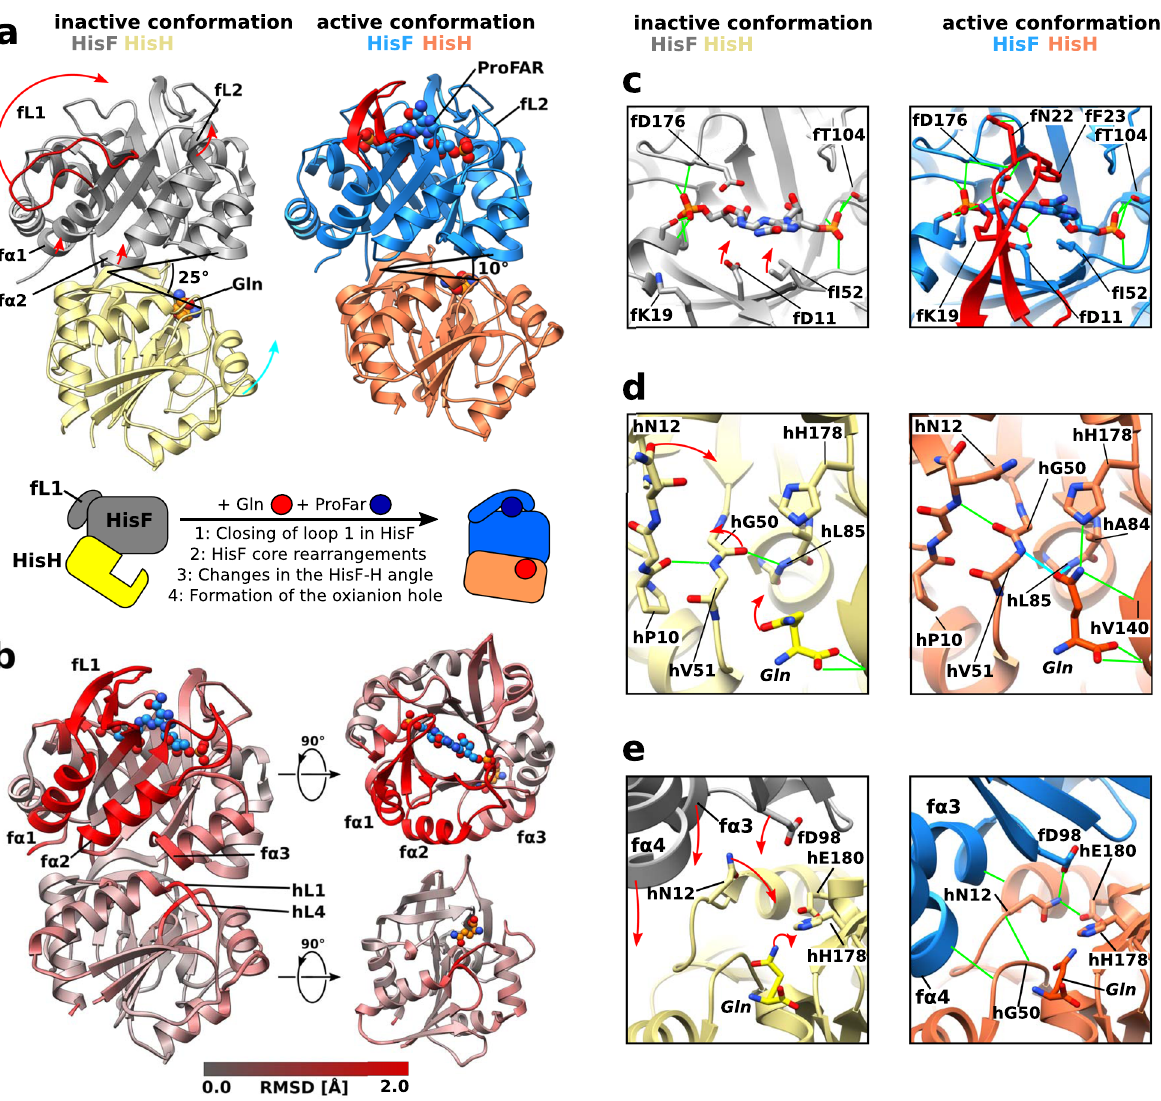
Fig. 2 Structural changes in the HisFH complex upon allosteric activation. a Crystal structure of the HisFH complex (hC84A) in the inactive conformation (HisF in gray, HisH in yellow; PDBID: 7AC8, chains C/D) bound to Gln (left) and in the active conformation (HisF in marine, HisH in orange, chains E/F) bound to ProFAR and Gln (right). The largest structural differences between the two conformations are observed in HisF (red arrows). The reorientation of HisH relative to HisF is indicated by a cyan arrow and leads to a reduction of the angle between fF120, hW123 and hG52 (C α atoms) from 25° to 10°. The major structural changes between the inactive and active conformations are indicated as cartoons. b The local backbone RMSD between the inactive and active conformations (PDBID 7AC8, chains C/D and E/F), after individual alignment of the proteins, mapped onto the structure of the active conformation. c Closeup of the HisF active site: Comparison between the inactive (left; PDBID 7AC8; chain A) and the active conformation (right; PDBID 7AC8, chain E). Important hydrogen bond interactions are shown in green. fL1 is shown in red. The compaction of the HisF active site in the active conformation is indicated by red arrows. d Oxyanion hole formation in the active conformation of HisH: The oxyanion hole is not formed in the inactive conformation (left; PDBID 7AC8, chain D). Red arrows indicate important conformational changes upon formation of the active conformation. The oxyanion hole (right; PDBID 7AC8, chain F) is formed by the rotation of the hG50/hV51 amide group. The side chain of the substrate Gln rotates into the oxyanion hole and forms hydrogen bonds to hG50 and hL85 (cyan). Other hydrogen bonds are shown in green. e The rearrangement of the HisF – HisH interface moves f α 3/ α 4 and fD98 closer to the active site (red arrows). Upon transition from the inactive (left; PDBID 7AC8, chains C/D) into the active conformation (right; PDBID 7AC8, chains E/F) fD98 moves by 3.6 Å and interacts with hN12. Additional backbone hydrogen bonds are formed that connect hL4 and h α 1 in HisH with f α 4 and f α 3 in